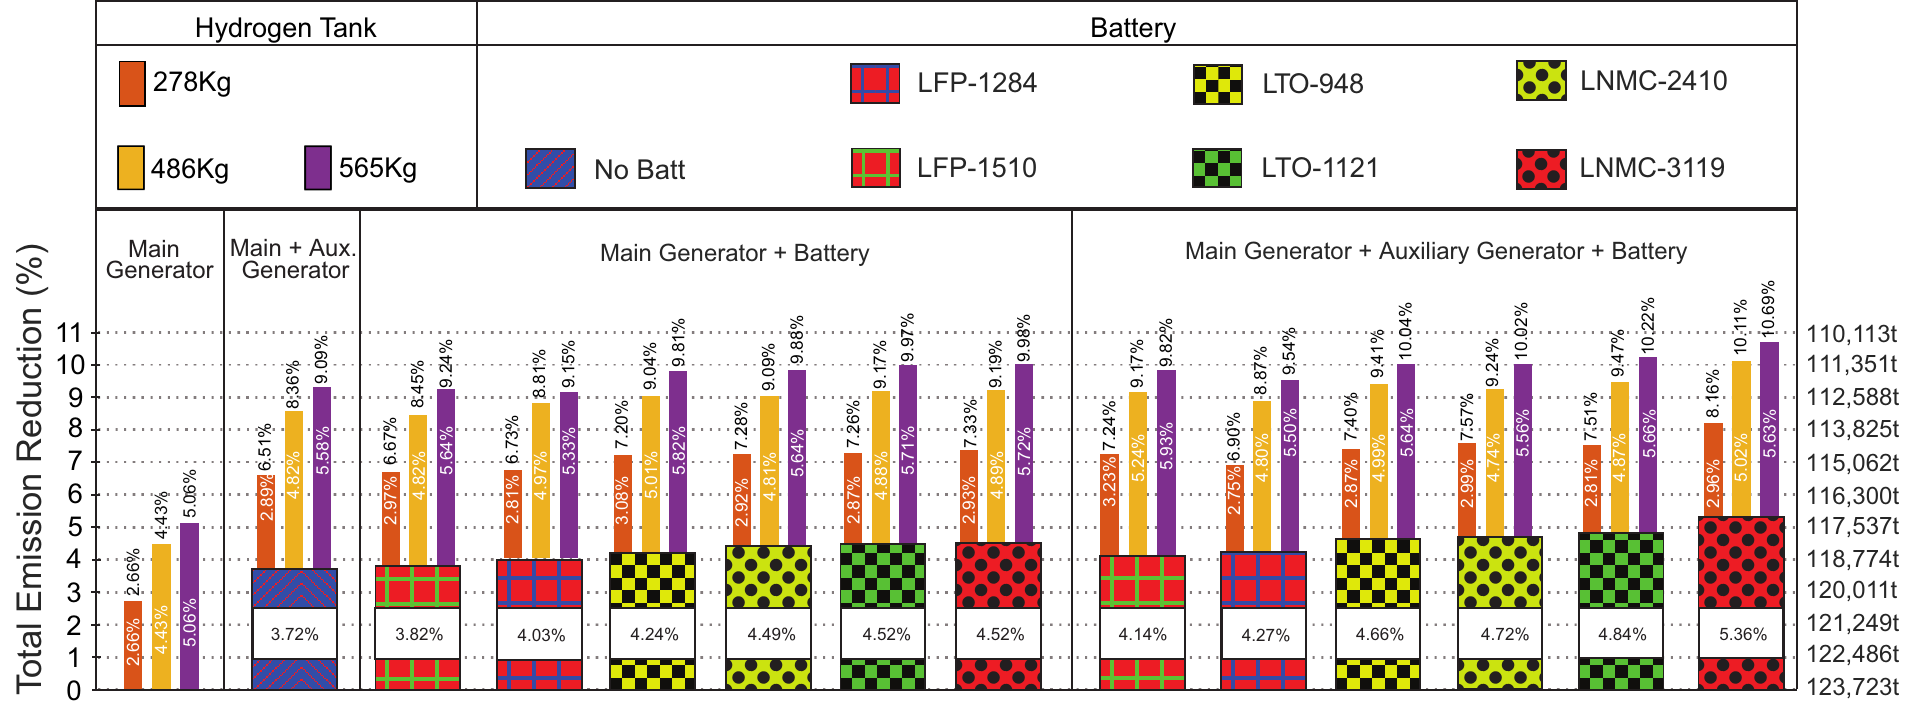
Figure 8. Total emission reduction results obtained from the configurations operating at 10% lower